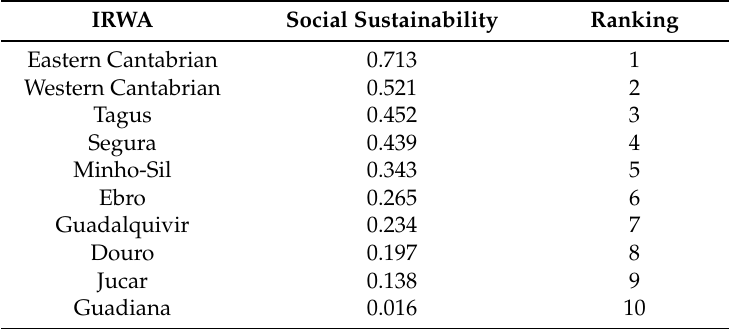
Table 8. Social sustainability of IRWA.